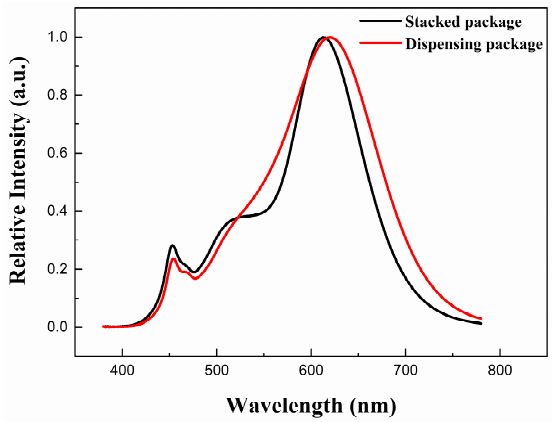
Figure 7. EL spectra of traditional dispensing packaged filament and stacked-type packaged filament.